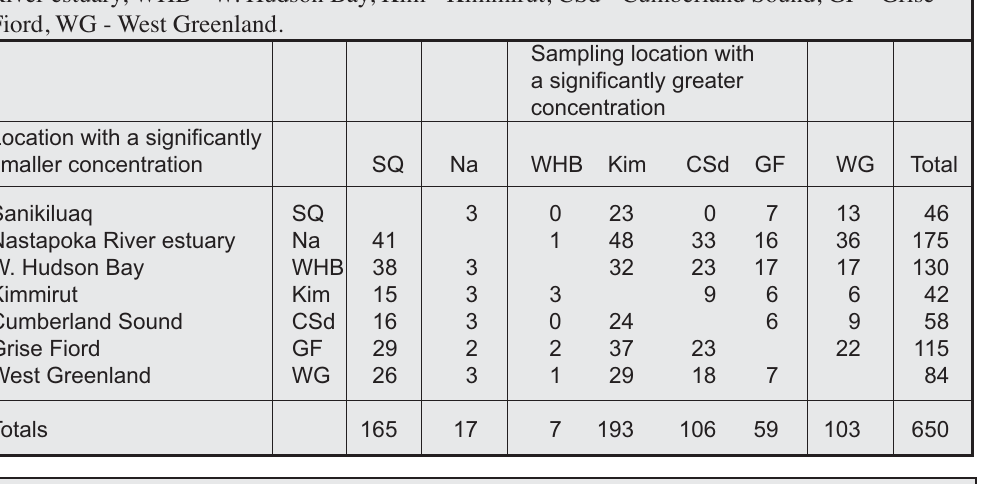
Table 3 . Canonical structure and Standardized (mean = 0 , s =1) Canonical Coefficients for the 49 organochlorine compounds used in the analysis. Other compounds used in the univariate analysis and not selected for CDA are also shown. The magnitude of the coefficient indicates its relative contribution to the discrimination of the sampling